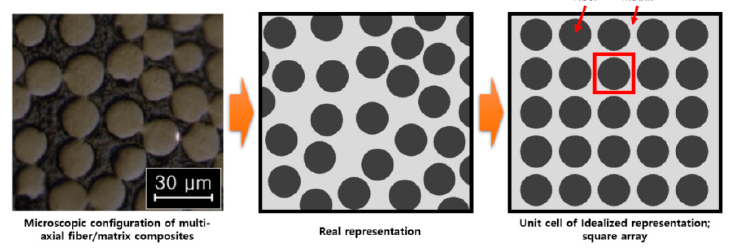
Figure 1. The assume structure composites of periodic; square array [16].